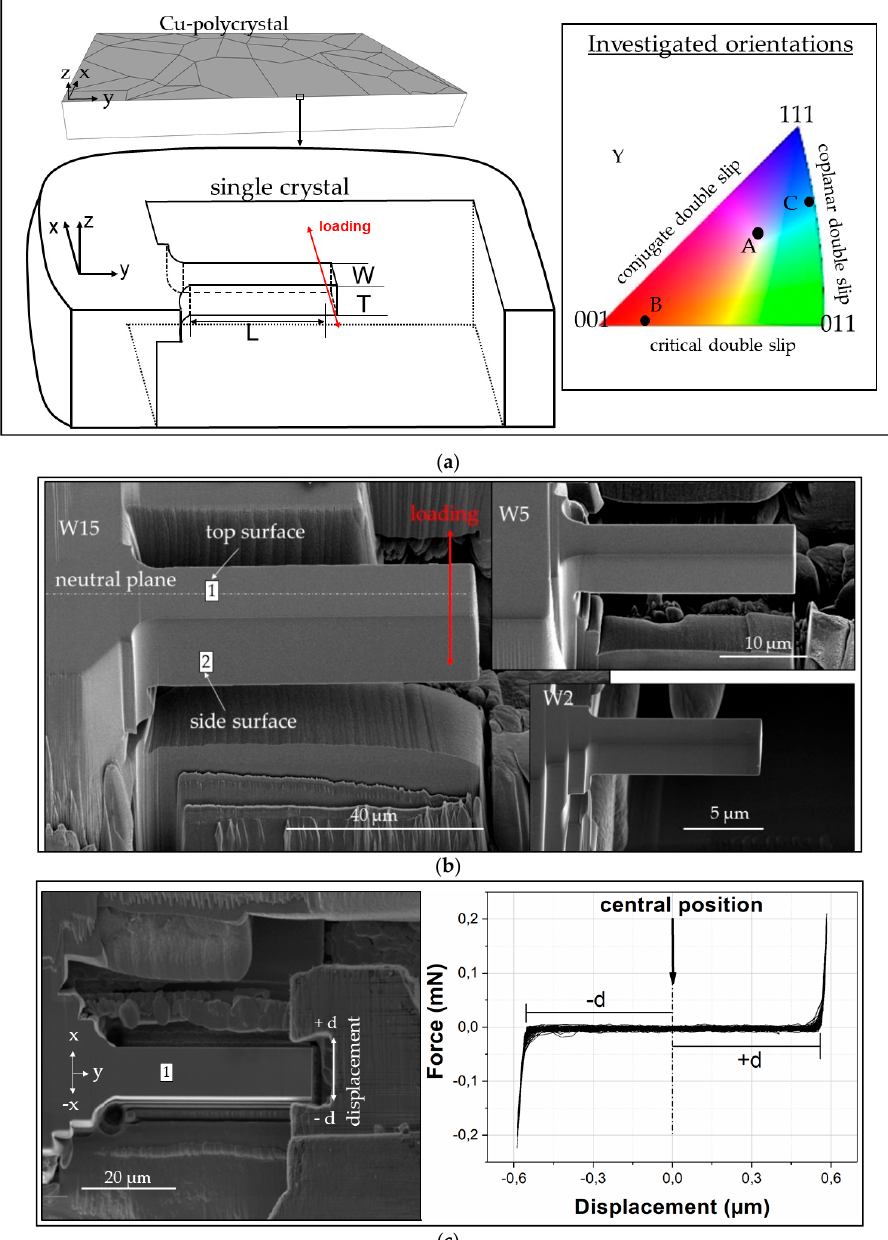
Figure 1. ( a ) Schematic representation of the used microbeam geometry with a square cross-section and an aspect ratio 4:1 (W:L), where the loading direction is parallel to the x direction. The crystallographic orientations used for single slip (SS), critical double slip (DS), and coplanar double slip (DS) are marked with A, B, and C, respectively in the standard stereographic triangle. The orientations in the triangle indicate the direction parallel to the neutral plane of the beam. ( b ) Representative SEM images of three microbeams with a width of 15, 5, and 2 µ m before fatigue testing and ( c ) the end alignment of the gripper and beam, as well as the elastic force-displacement curve (see text for